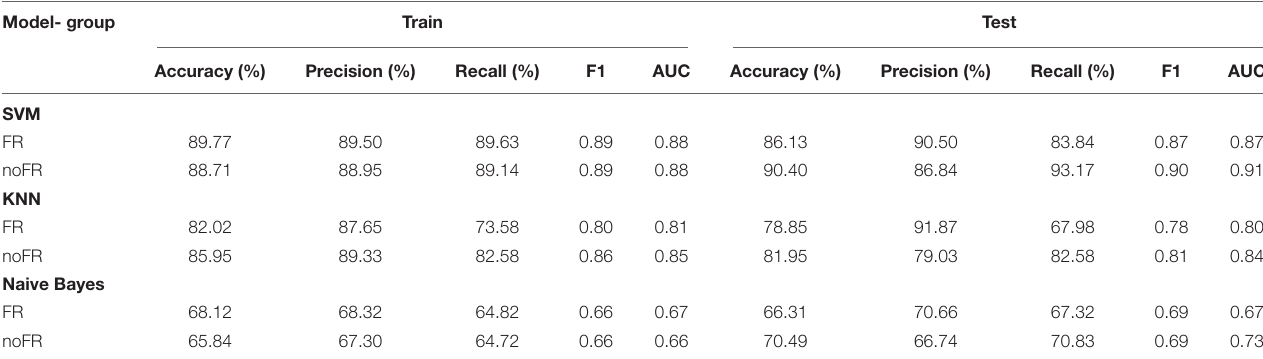
TABLE 6 | Results of classifying cue and background based on all six frequency bands. Model- group